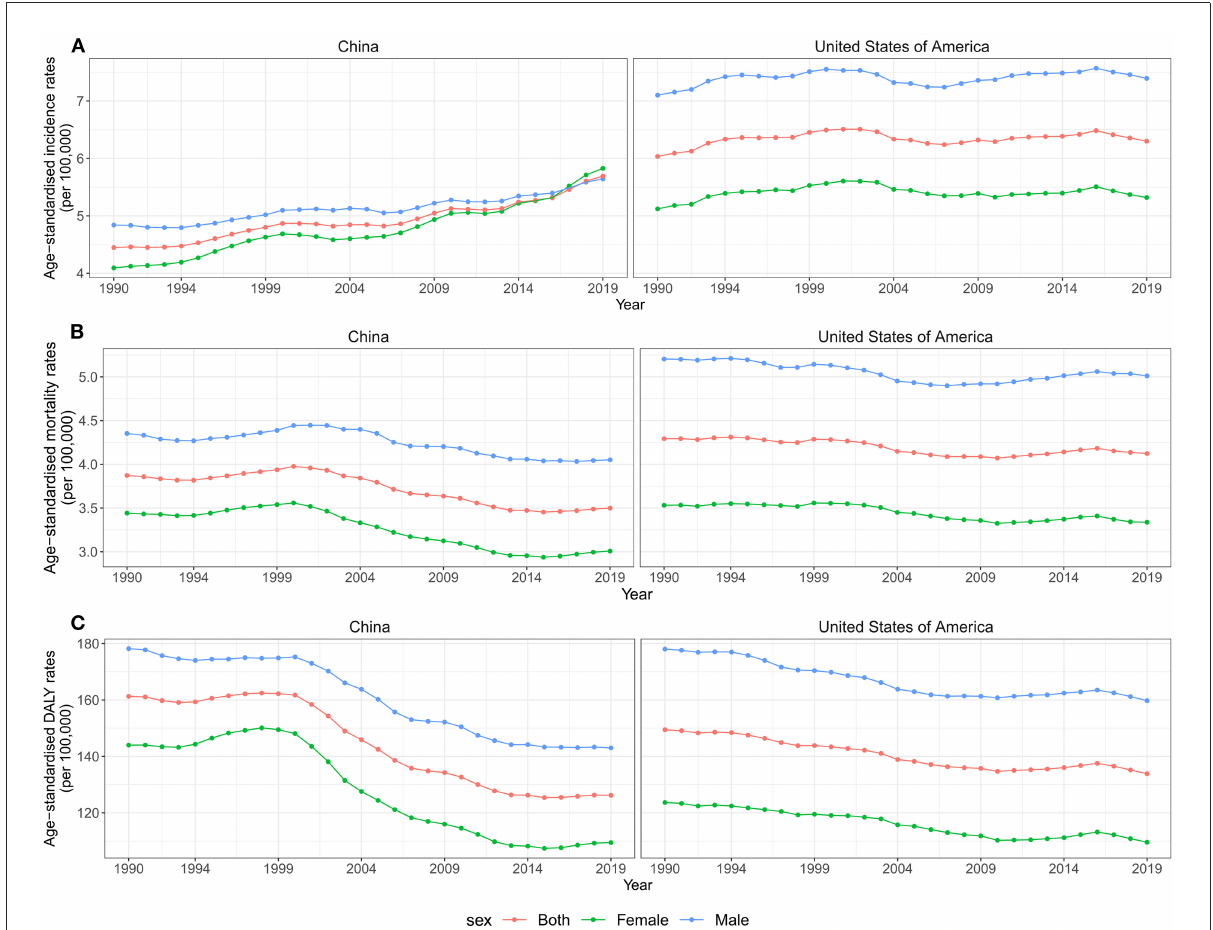
FIGURE1 Trends for ASIR, ASMR, and ASDR of brain and CNS cancer by sex in China and the US from 1990 to 2019. (A) ASIR of brain and CNS cancers for both sexes in China and the US from 1990 to 2019. (B) ASMR of brain and CNS cancers for both sexes in China and the US from 1990 to 2019. (C) ASDR of brain and CNS cancers for both sexes in China and the US from 1990 to 2019. ASIR, age-standardized incidence rate; ASMR, age-standardized mortality rate; ASDR, age-standardized disability-adjusted life years rate; CNS, central nervous